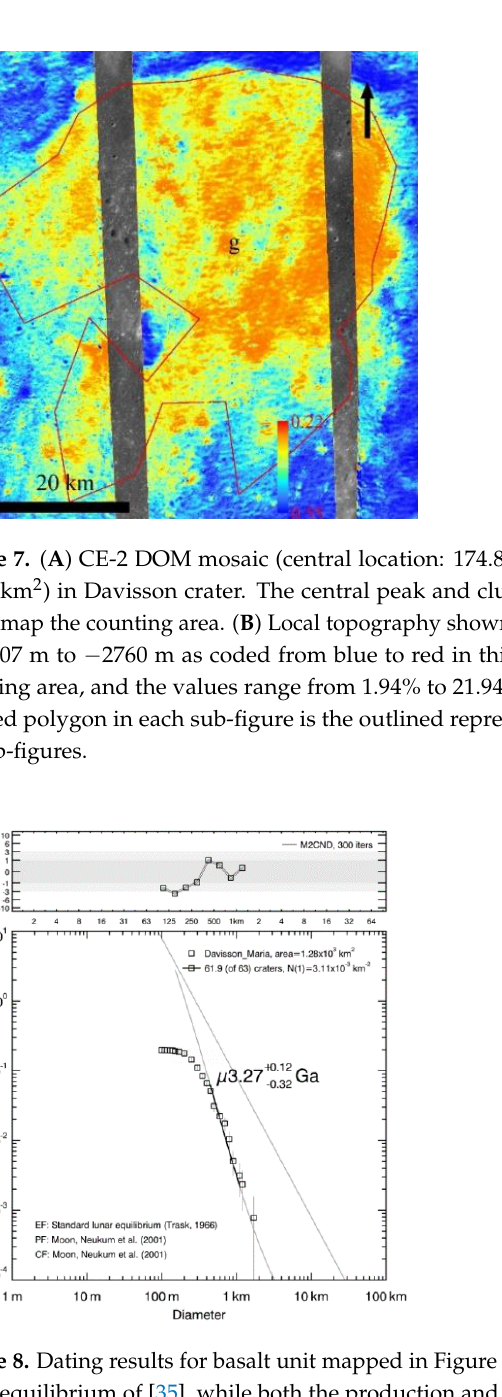
Figure 8. Dating results for basalt unit mapped in Figure 7. The equilibrium function is the standard lunar equilibrium of [35], while both the production and chronology functions are from [36].